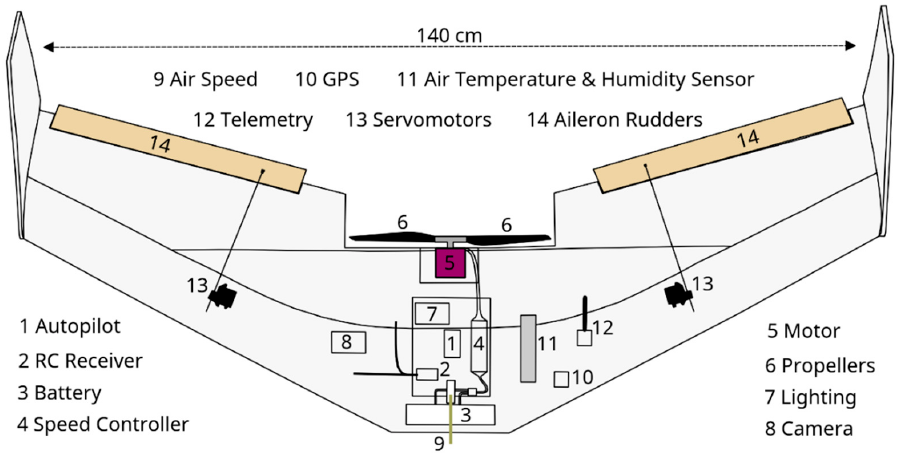
Figure 2. Setup of the low-cost UAV (flying wing model).